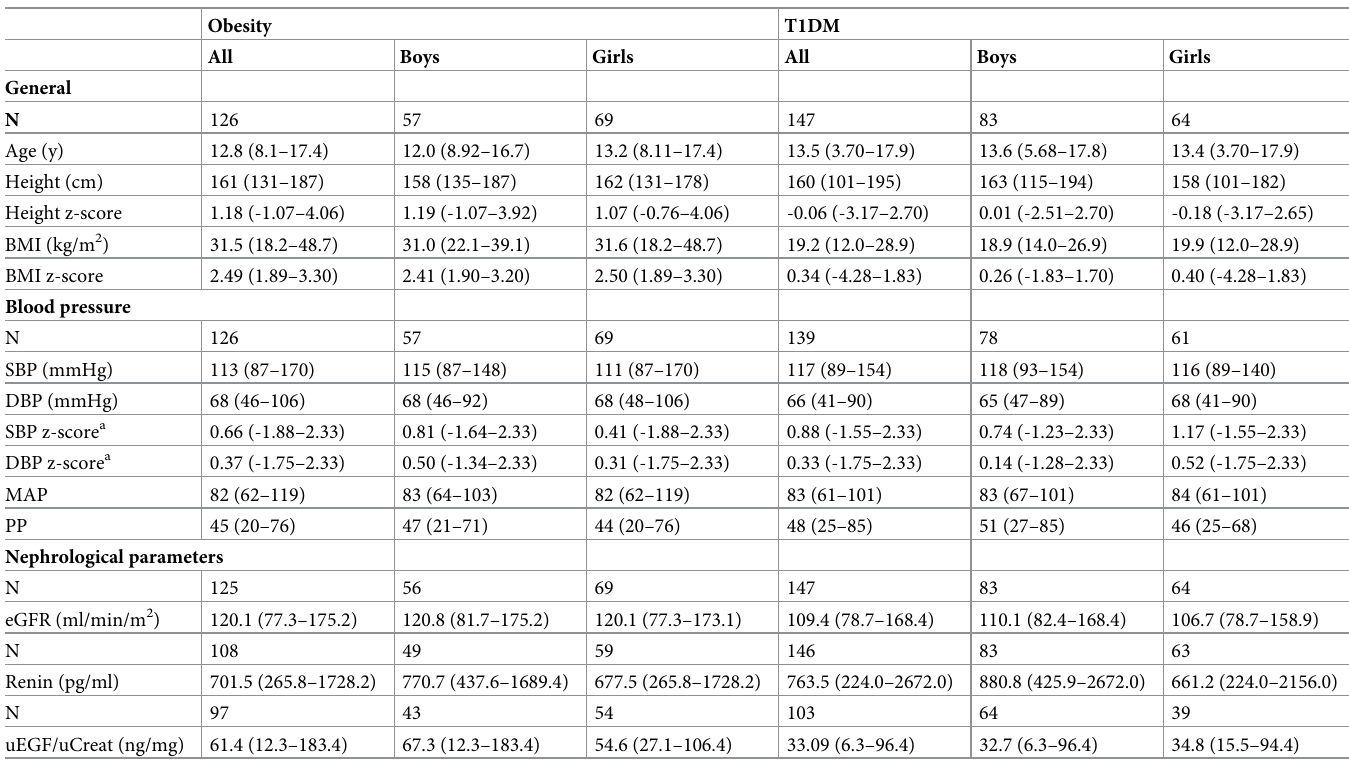
Table 1. Characteristics of patients with obesity and T1DM.